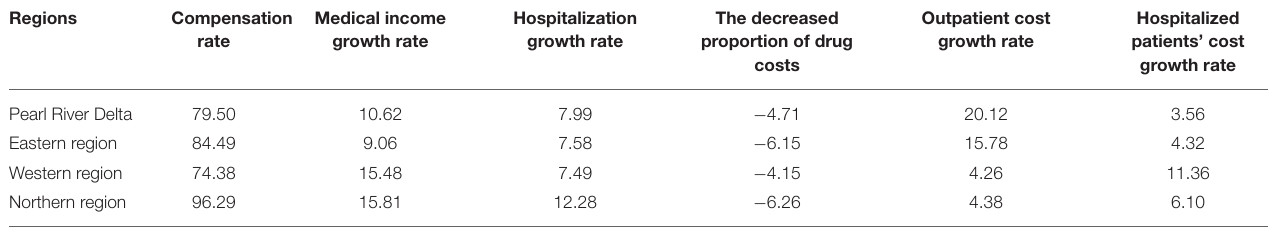
TABLE 3 | Index values of different regions (%).